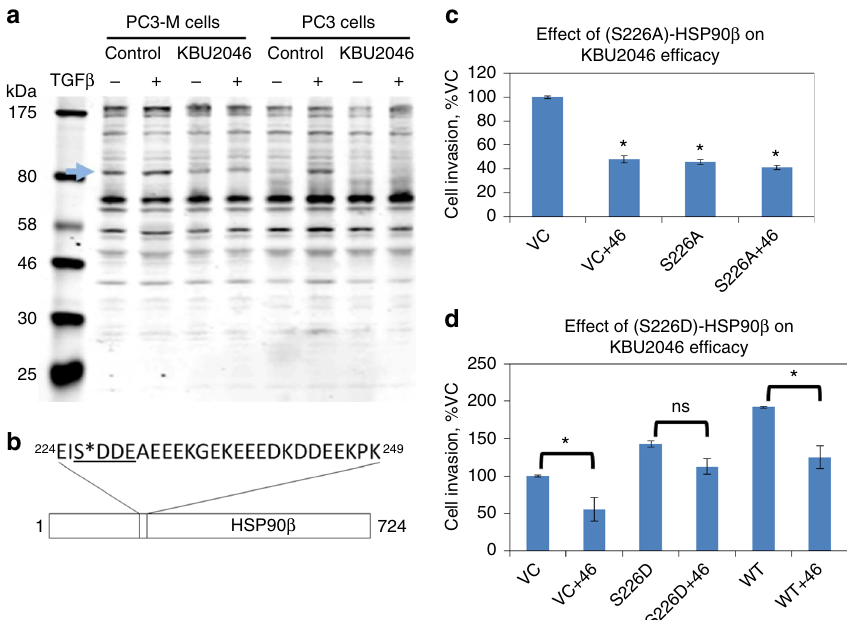
Fig. 4 KBU2046 decreases phosphorylation of HSP90 β . a Probing for KBU2046-induced changes in protein phosphorylation. PC3-M or PC3 cells were pre- treated with 10 µ M KBU2046 for 3 days, then with ±TGF β and the resultant cell lysate probed for changes in protein phosphorylation with the KinomeView ® assay. The depicted western blot utilizes KinomeView ® phospho-motif antibody, BL4176; the blue arrow denotes an 83 kDa band whose phosphorylation is inhibited by KBU2046 (see Supplementary Fig. 10 for complete KinomeView ® assay screening data). b Proteomic analysis. PC3 cells were pre-treated with KBU2046 or vehicle, then with TGF β , proteins from the resultant cell lysate were immunoprecipitated with BL4176, and HSP90 β was identi fi ed by LC-MS/MS analysis (see Supplementary Fig. 12 for expanded proteomic assay data). The phospho-motif recognized by the antibody is underlined; S* — denotes Ser226, whose phosphorylation is decreased by KBU2046. c , d The phospho-mimetic changes in HSP90 β Ser 226 structure regulate human PCa cell invasion and KBU2046 ef fi cacy. PC3-M cells were transfected with S226A-, S226D-, or WT-HSP90 β , or empty vector (VC), treated with KBU2046 or vehicle, and cell invasion measured. Values are the mean ± SEM of a representative experiment of multiple experiments (all in replicates of N = 3); *denotes t -test P value <0.05 between bracketed conditions, or compared to